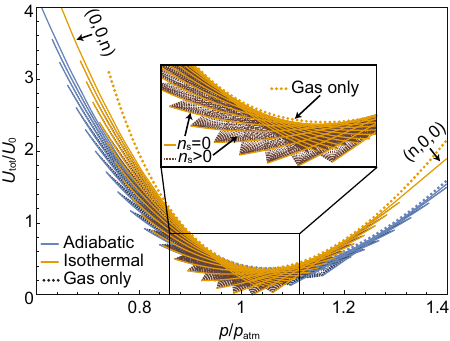
Fig. 2 Multiple possible internal energy states of a meta fl uid. The fi gure presents analytical results for U tot / U 0 , vs. pressure, p / p atm , where U = Φ p v 0 atm atm . All system parameters were taken from experimental measurements and are de fi ned below (see caption of Fig. 4). Adiabatic and isothermal cases are shown by blue and orange lines, respectively, where dashed lines denote states with bi-stable elements in the spinodal ( n s ≠ 0). Dotted curves of the corresponding colors represent the energy-pressure relation for an ideal gas. The multiple possible internal energies per external pressure allow to store, or release, energy at atmospheric conditions. The density of possible states decreases as the distance to the global minimum